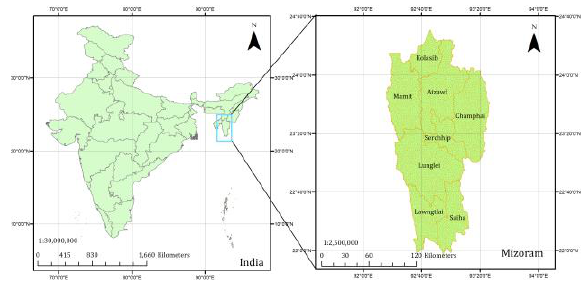
Figure 1: Map drawn using ArcMap showing the study area of Mizoram, North East